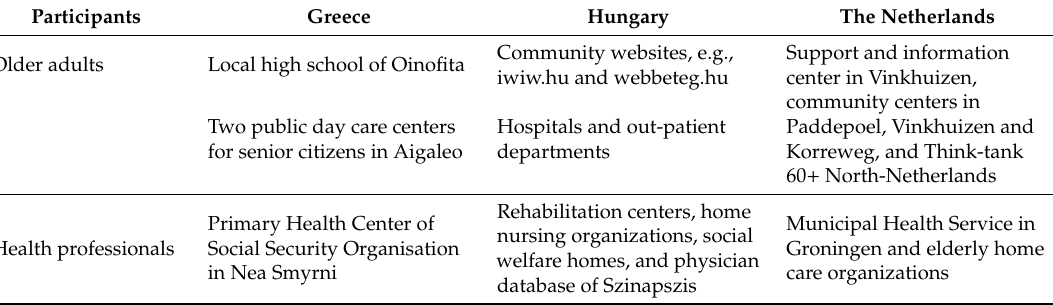
Table 2. Strategies for participant recruitment in the three